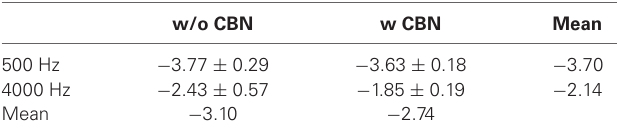
Table 1 | Slope (in units of dB/ln(ms)) of the threshold-vs.-duration functions . w/o CBN w